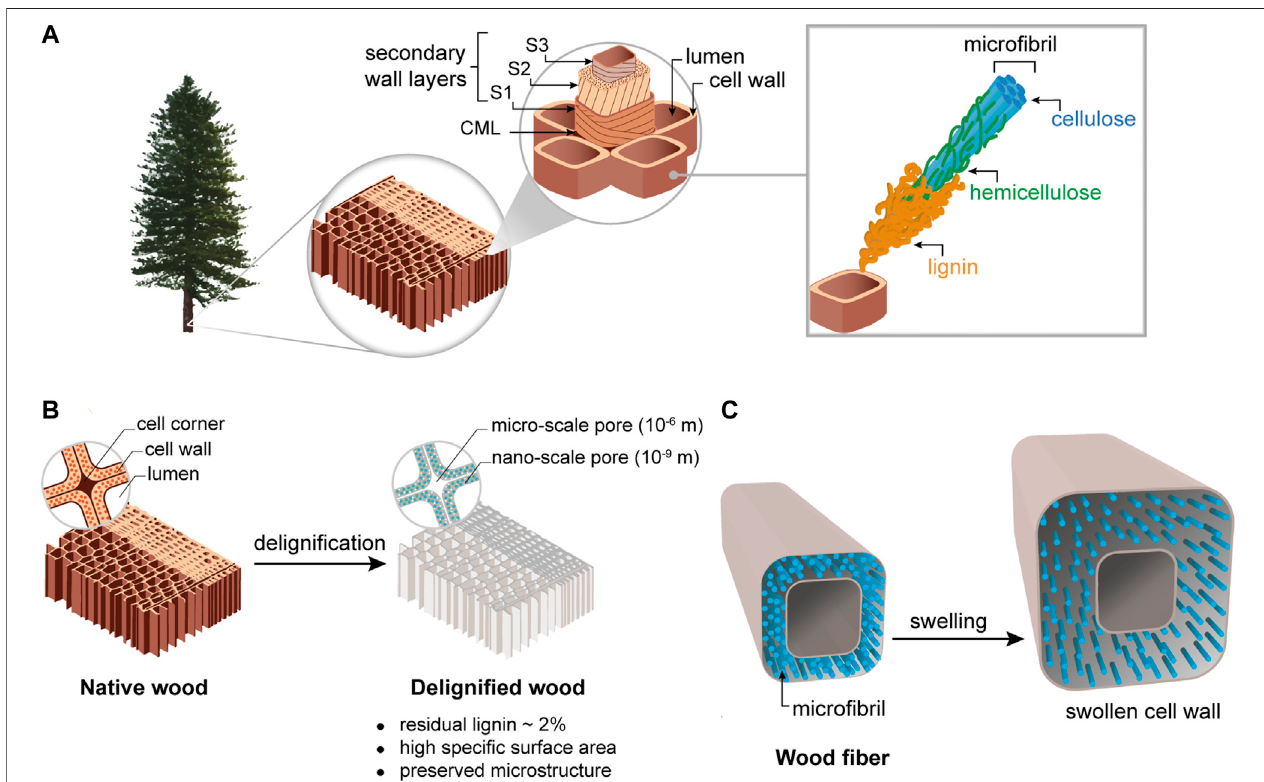
FIGURE2|(A) Illustrationofsoftwoodmicrostructureandmajorcellwallcomponents,thestartingtissuefornanostructuralmodi fi cation.Thecellwallisdominated by the middle lamella, and the thick secondary wall. The cellulose nano fi brils are reinforcing a hydrated mixture of hemicellulose and lignin polymers in the cell wall. (B) Wood substrate before and after deligni fi cation treatment. Porosity is generated also at nanoscale inside the cell wall. (C) Illustration of wood cell wall swelling, which facilitates chemical modi fi cation.